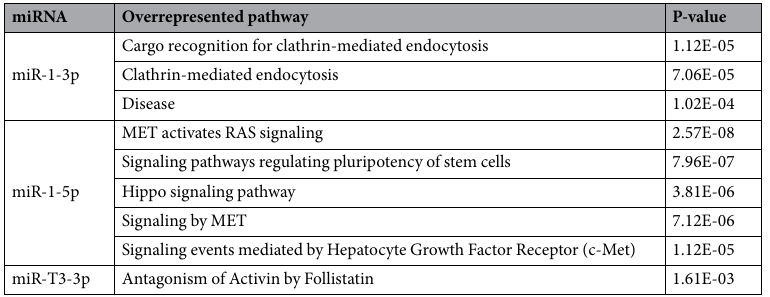
Table 5. Human biological pathways potentially regulated by the most abundant miRNA target